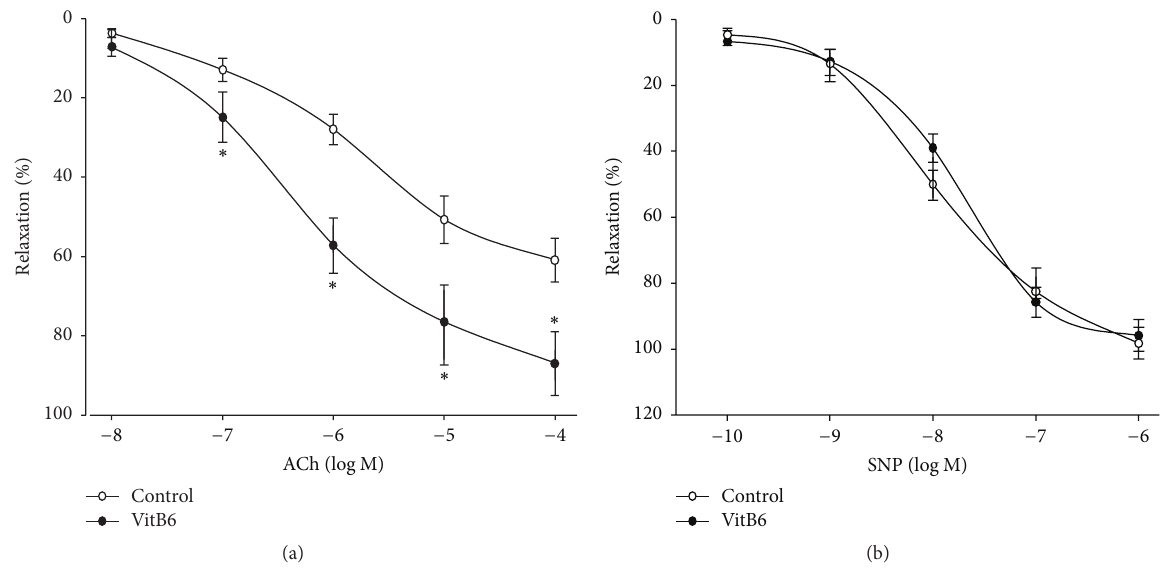
Figure 1: Administration of VitB6 prevents endothelial dysfunction in 𝐴𝑝𝑜𝑒 −/− mice fed with high-fat diet. Male 𝐴𝑝𝑜𝑒 −/− mice at the age of 6 weeks received high-fat diet and VitB6 (50mg/kg/day) administration in drinking water for 8 weeks. At the end of experiments, mice were sacrificed under anaesthesia. The descending aortas were isolated and cut into rings. (a) ACh-induced endothelium-dependent relaxation and (b) SNP-induced endothelium-independent relaxation were determined by organ chamber as described in Section 2. All data were expressed as mean ± SEM. 𝑁 is 10–15 in each group. ∗ 𝑃 < 0.05 versus control.